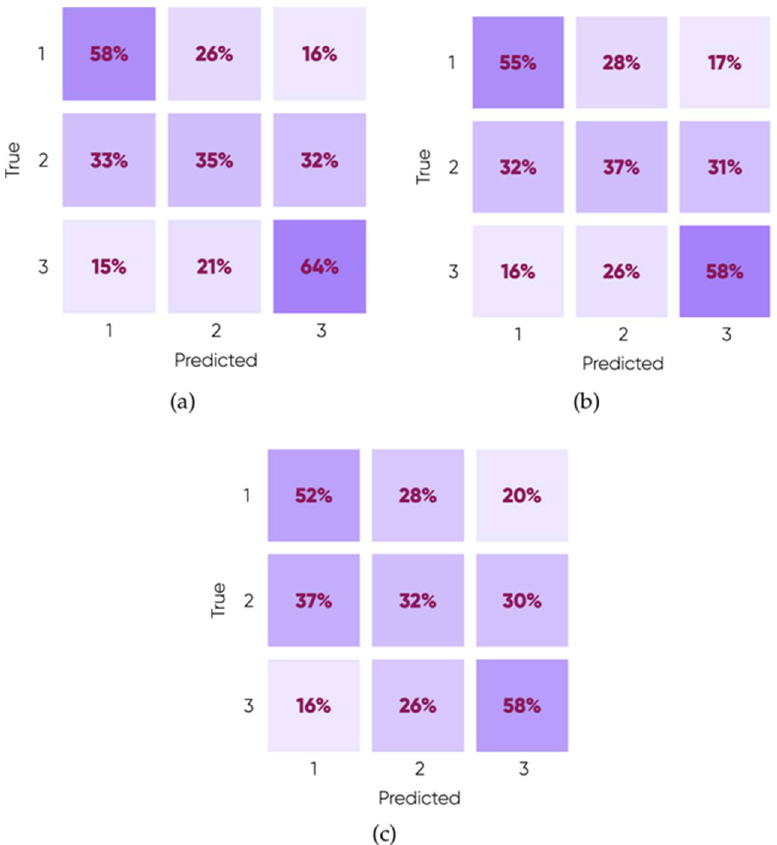
Figure 7. Confusion matrix showing the classification power of the SVM in identifying the three categories of rough ice adhesion surfaces with epsilon values of 0.05 ( a ), 0.1 ( b ), and 0.2 eV( c ). The three classes of surfaces, 1, 2, and 3, refer to low, medium, and high ice adhesion strengths. The classification accuracy of each class is given in the figure, with a high intensity of the color also representing a high accuracy. The “Ture” classes shown in the confusion matrix are randomly discretized from the MD simulation results.